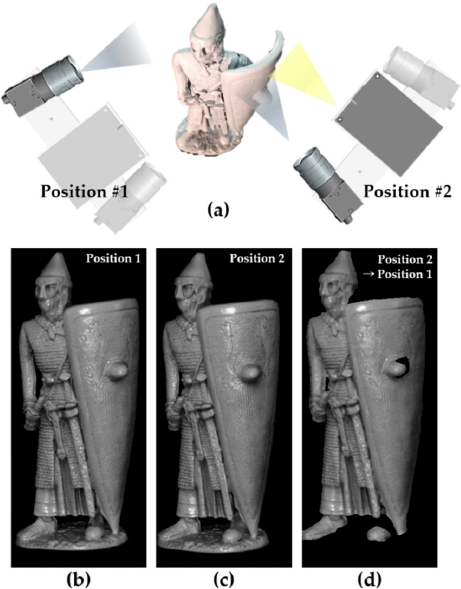
Figure 5. ( a ) Image re-projection in two different positions; ( b ) Reference view image taken from left camera at position #1; ( c ) Other view image taken from left camera at position #2; ( d ) Re-projected image from the other view to the reference view which shows data acquired from position #2 in the perspective of camera #1.